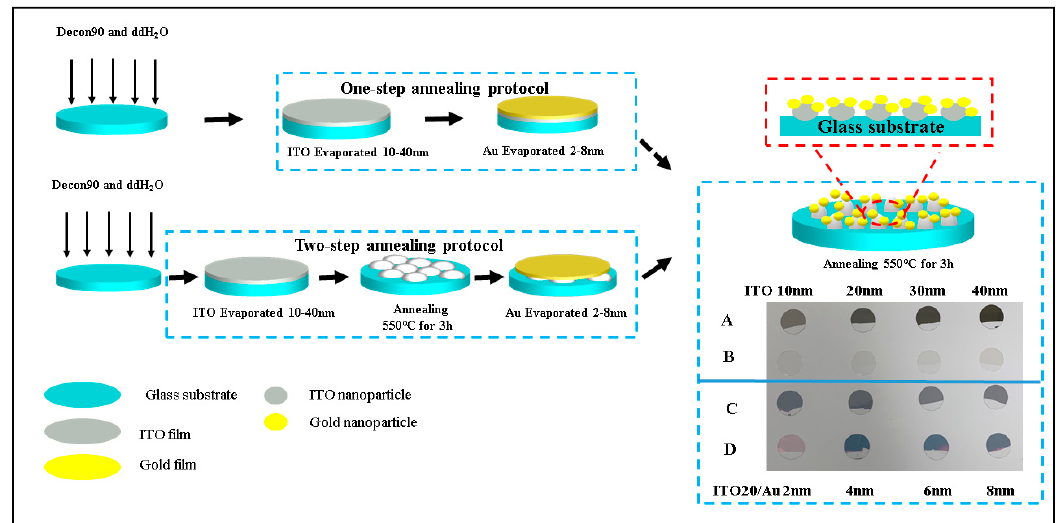
Figure 1. Evaporation and annealing of different indium tin oxide (ITO) thicknesses on round glass coverslips by either the one-step or two-step annealing protocol coated with ITO-20 nm/Au-(2–8 nm) nanoparticles (NPs).